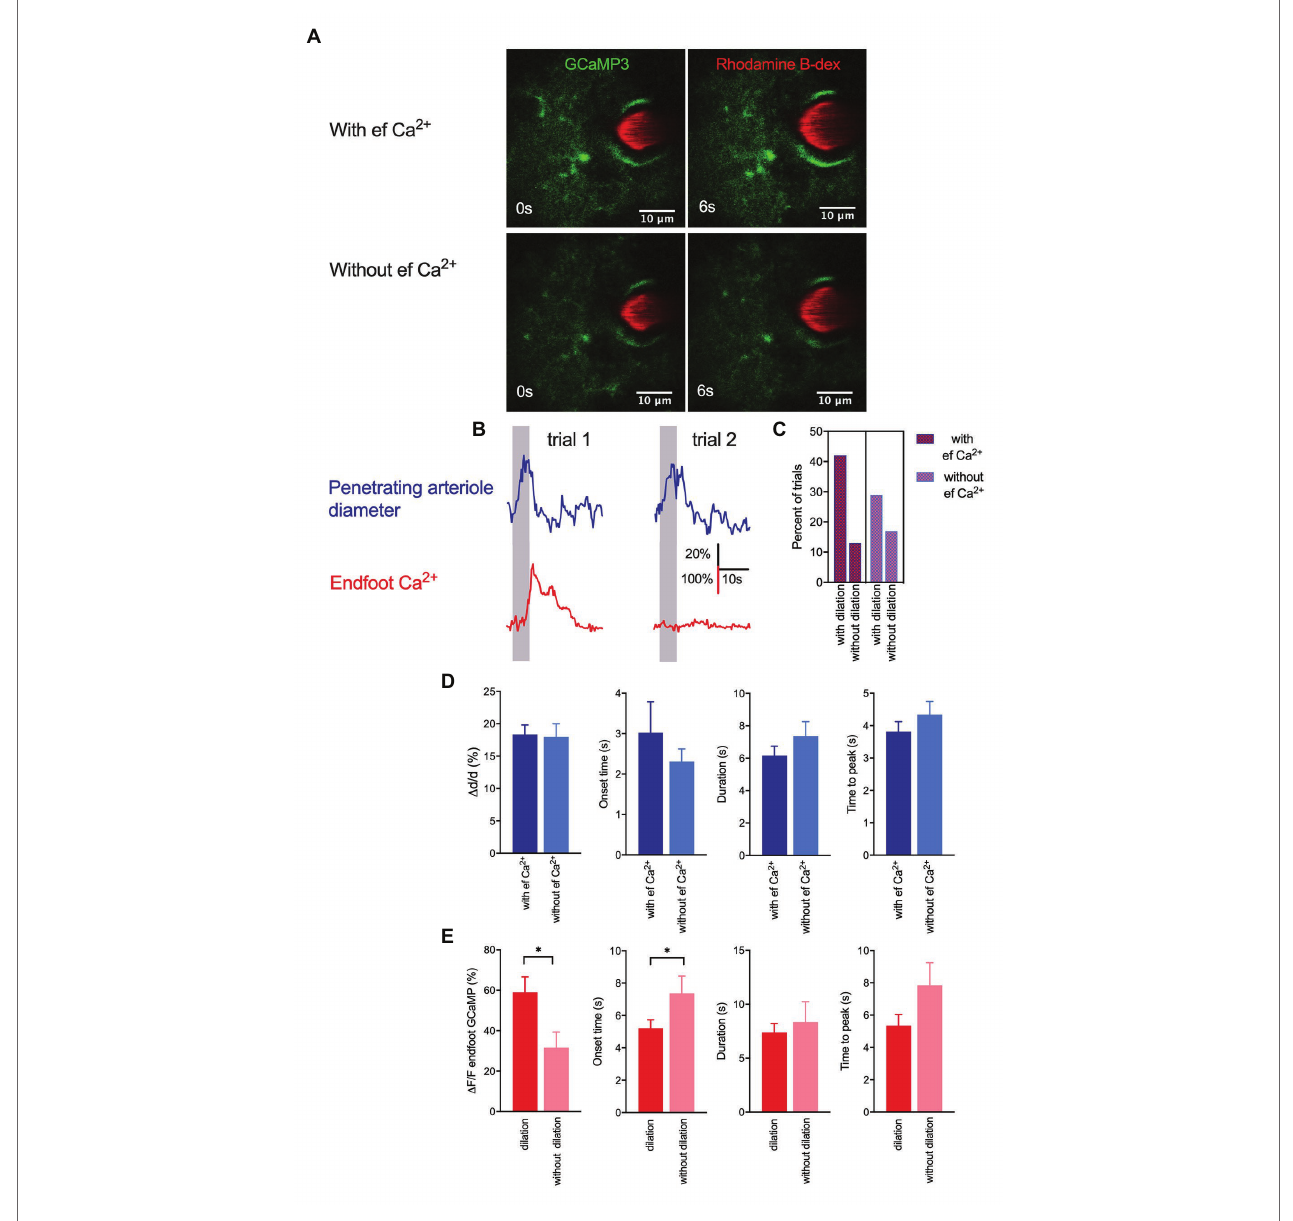
FIGURE 2 | Whisker stimulation-induced arteriole dilation occurs in the absence of astrocytic endfoot Ca 2+ but vasodilation augmented endfoot Ca 2+ . (A) Representative images from two different trials showing a penetrating arteriole enwrapped by an endfoot of a GLAST-Cre ERT x GCaMP3 mouse immediately prior to (0 s) and in response to (6 s) whisker stimulation. (B) Representative traces showing penetrating arteriole diameter and changes in endfoot Ca 2+ (from A ) from the same mouse but different trials in response to a 5-s whisker stimulation. (C) Percentage of trials with and without dilation in the presence and absence of endfoot Ca 2+ . (D) Summary of percent peak change (i), onset time (ii), duration (iii), and time to peak (iv) of penetrating arteriole diameter in response to whisker stimulation in the presence or absence of endfoot Ca 2+ . (E) Summary of percent peak change (i), onset time (ii), duration (iii) and time to peak (iv) of endfoot Ca 2+ in response to whisker stimulation in the presence or absence of